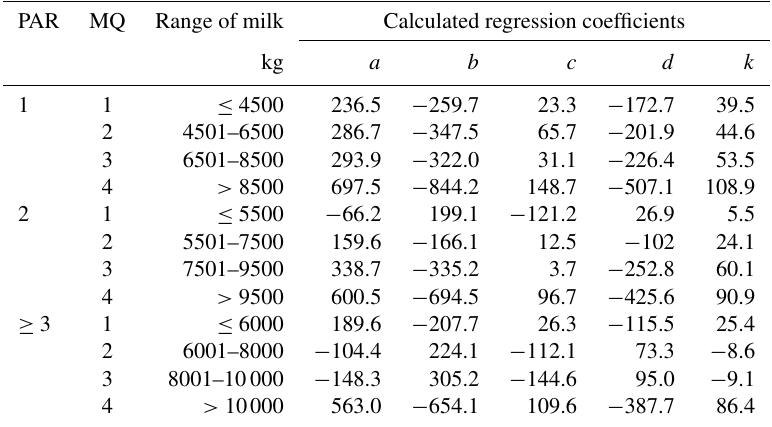
x : average. SD: standard deviation. Table 2. Regression coefficients calculated using Eq. (5) (Ali and Schaeffer, 1987) within parities (PARs) and the rank of milk production level (MQ) for the somatic cell count index estimation according to the stage of lactation. PAR MQ